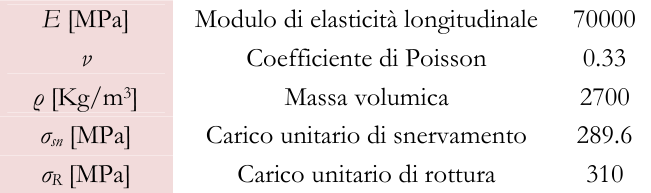
Tabella 1: Proprietà meccaniche della lega Al 6061-T6.